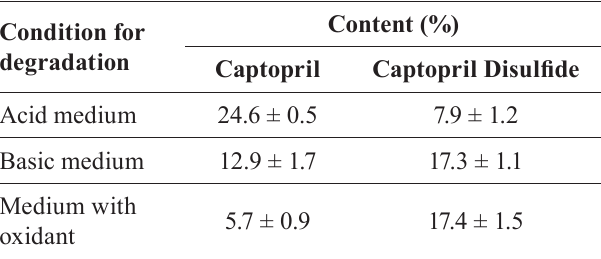
TABLE VII - Remaining concentrations of captopril and disulfide of captopril in the formulation after the forced degradation test Condition for